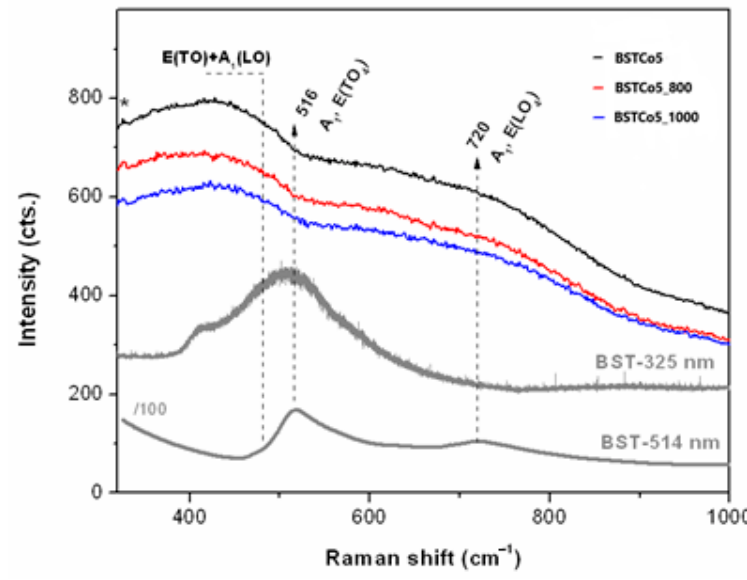
Figure 4. UV Raman spectra of the BST5Co samples compared with BST (*325 nm laser lines).